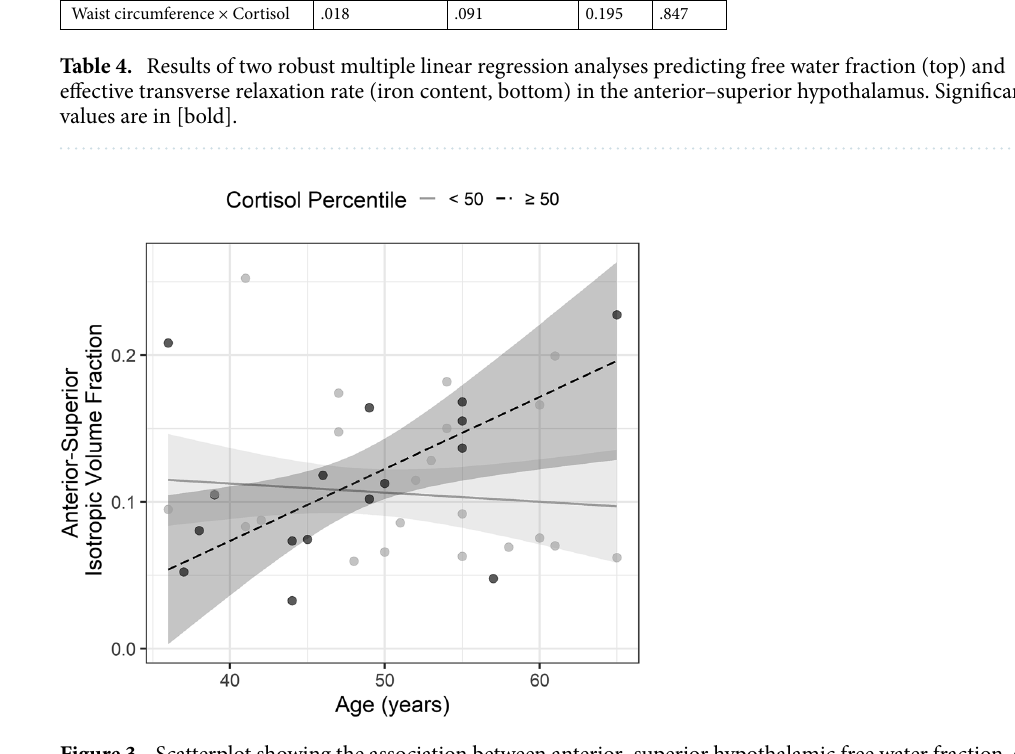
Figure 3. Scatterplot showing the association between anterior–superior hypothalamic free water fraction, age, and long-term cortisol. To display the interaction effect between age and cortisol, we divided the participants into two groups based on their age- and sex-dependent cortisol percentile (< 50 and ≥ 50